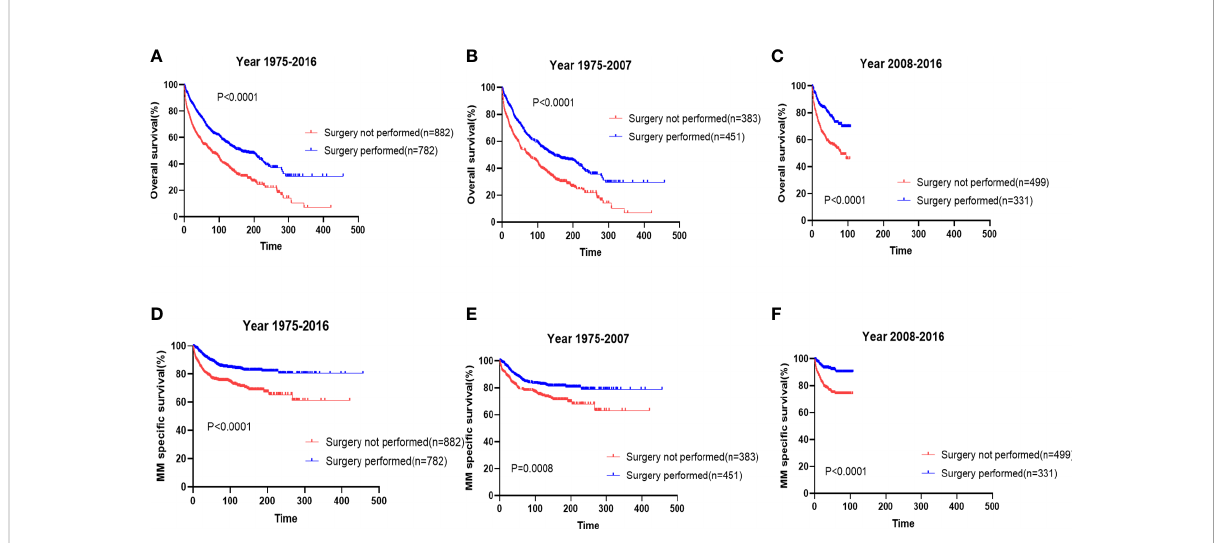
FIGURE 3 The prognostic effects of surgery on the overall survival (A) and myeloma-speci fi c survival (D) of patients with extramedullary plasmacytoma (EMP). The prognostic effects of surgery on the overall survival and myeloma-speci fi c survival of patients with diagnosed from 1976-2007 (B, E) and those diagnosed from 2008-2016 (C, F)